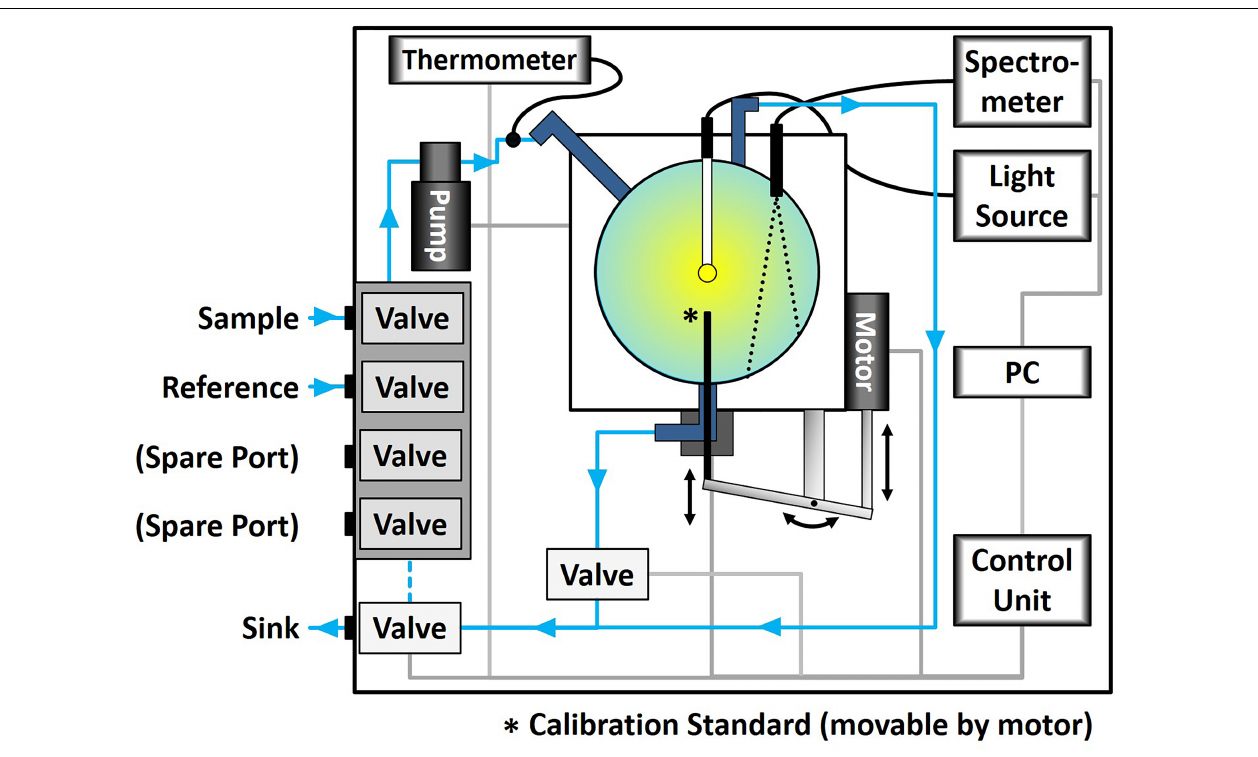
FIGURE 3 | Schematic setup of the Hyperspectral Absorption Sensor (HyAbS) equipped with the solid